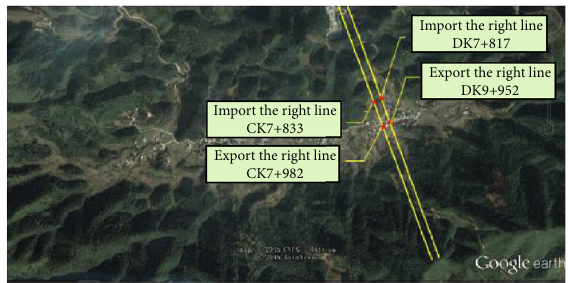
Figure 1: Layout of the Junchang